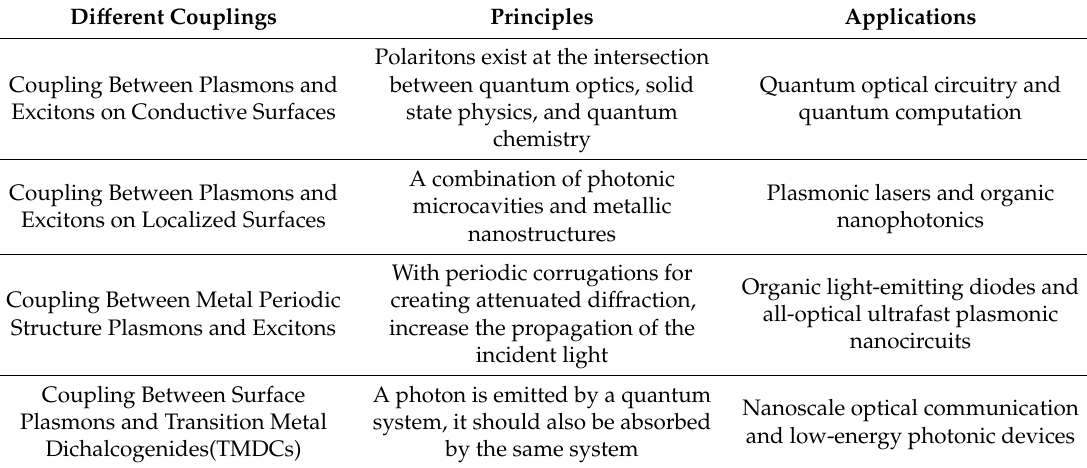
Table 1. Di ff erent coupling principles with their applications. Di ff erent Couplings